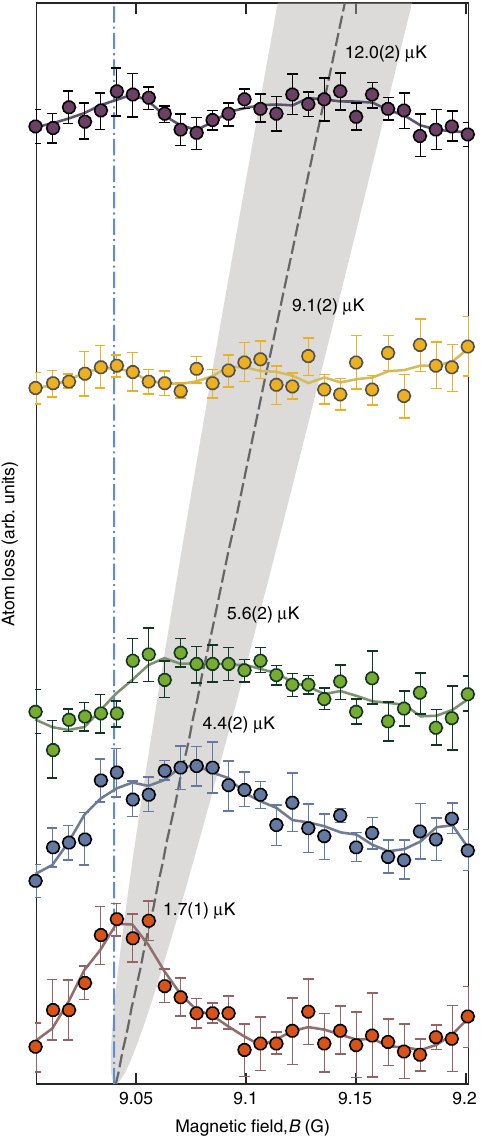
Fig. 2 Loss spectroscopy in an optical collider. Feshbach loss as a function of magnetic fi eld B for fi ve collision energies E nom / k B as annotated. Each data set has been vertically offset proportional to E nom ; a data point ( circle ) represents the mean of typically fi ve loss measurements with error bars denoting the standard error of the mean. The solid lines are a moving average to guide the eye. The threshold resonance position B 0 is indicated by a dot-dashed blue line , and the theoretically predicted shift in the resonance position is shown by a gray dashed line , surrounded by a shaded gray region displaying the expected collision energy spread δ E ∝ to the fi nite temperature of the cloud as discussed in the text and “ Methods direct simulation Monte Carlo method 30, 37 corroborates our interpretation of the secondary peak.